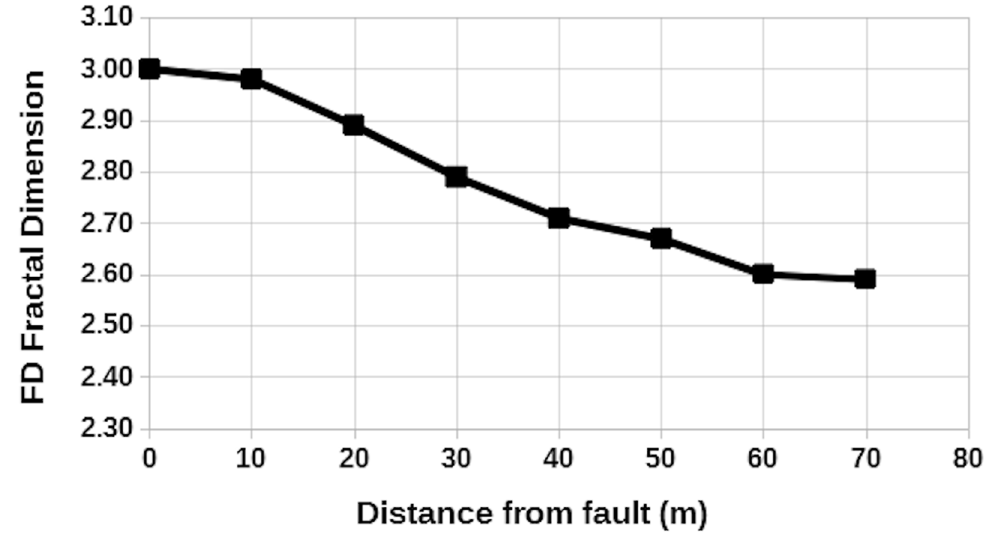
Figure 7. Fractal dimension values from the fault (at distance 0) to the different distances.